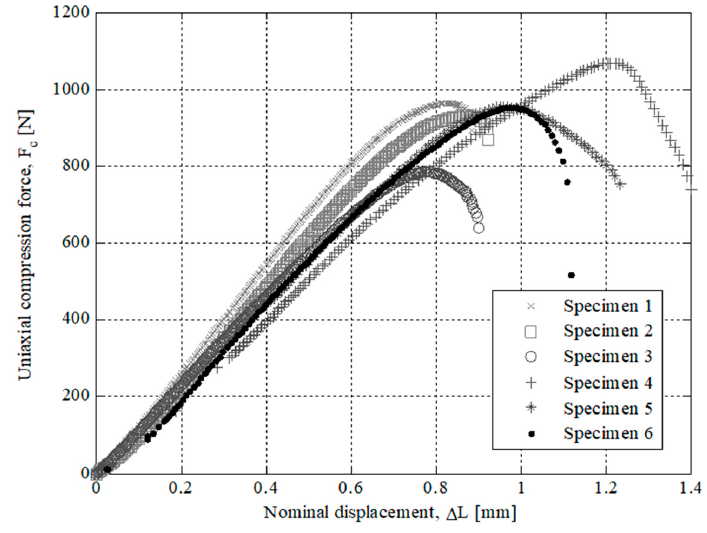
Figure 7. Curves for Z Axis manufactured specimens related to Uniaxial compression force versus nominal displacements.